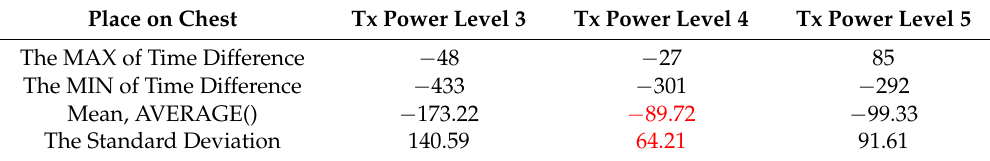
Table 5. Comparison of different Tx power levels with the BLE Tag on the chest. Place on